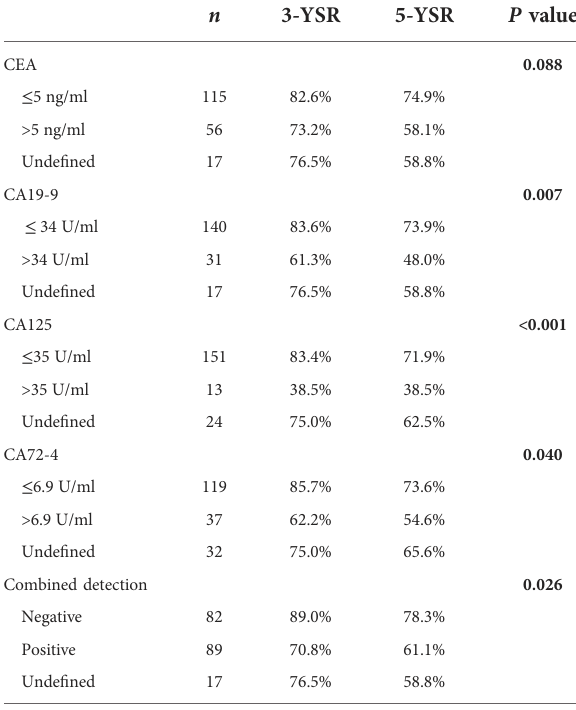
TABLE 4 Univariate analysis of tumor makers for patients with colon cancer. Tumor